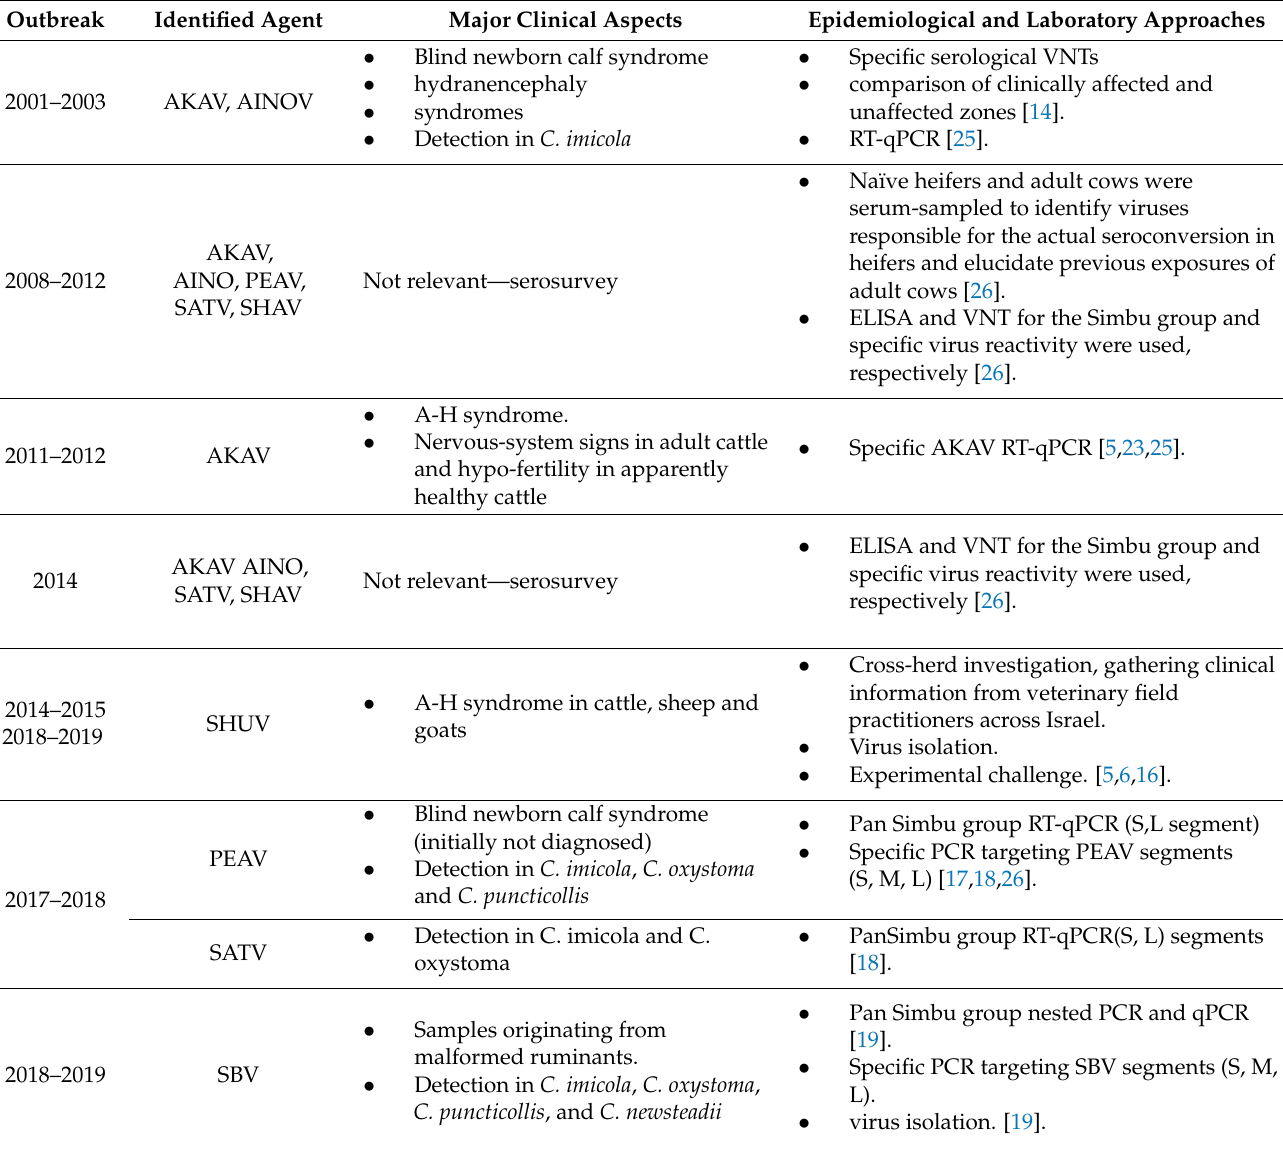
Table 1. Significant clinical and epidemiological tools demonstrate the presence of Simbu serogroup viruses in Israel